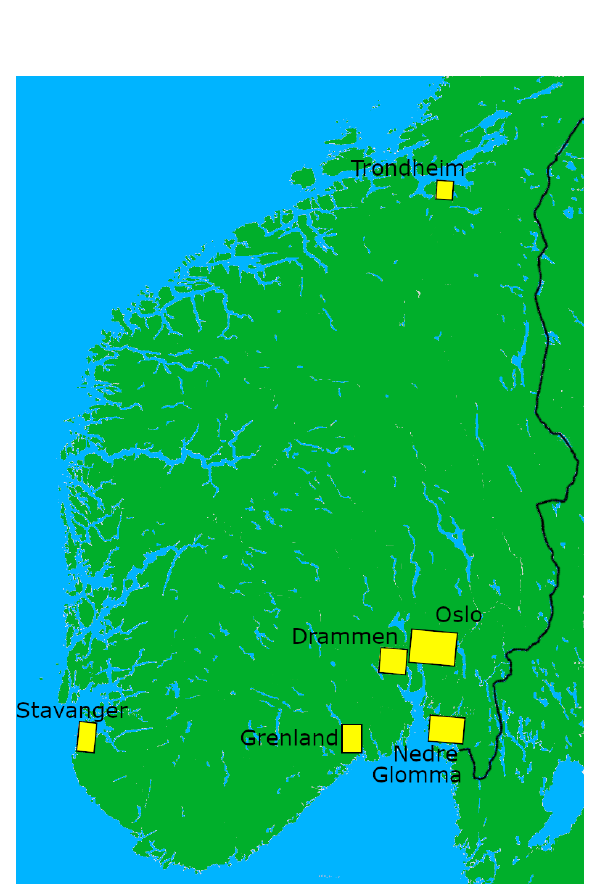
Figure 3. A map of the southern part of Norway showing the loca- tion and extent of the six modelling domains Stavanger, Trondheim, Grenland, Drammen, Oslo, and Nedre